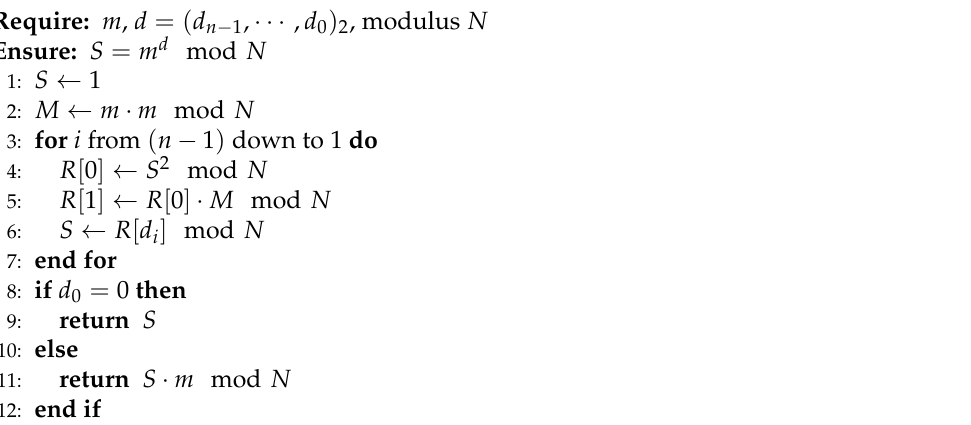
Algorithm 4 Modified Square-and-Multiply Always, Left to